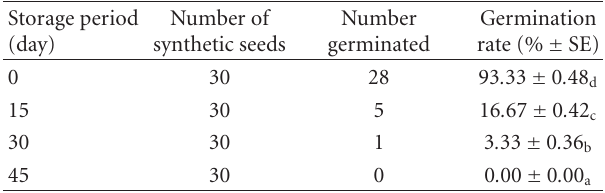
Table 3: E ff ect of storage period (day) at 4 ± 1 ◦ C on germination of synthetic seeds of Oryza sativa L. Cv. MRQ 74 on MS basal